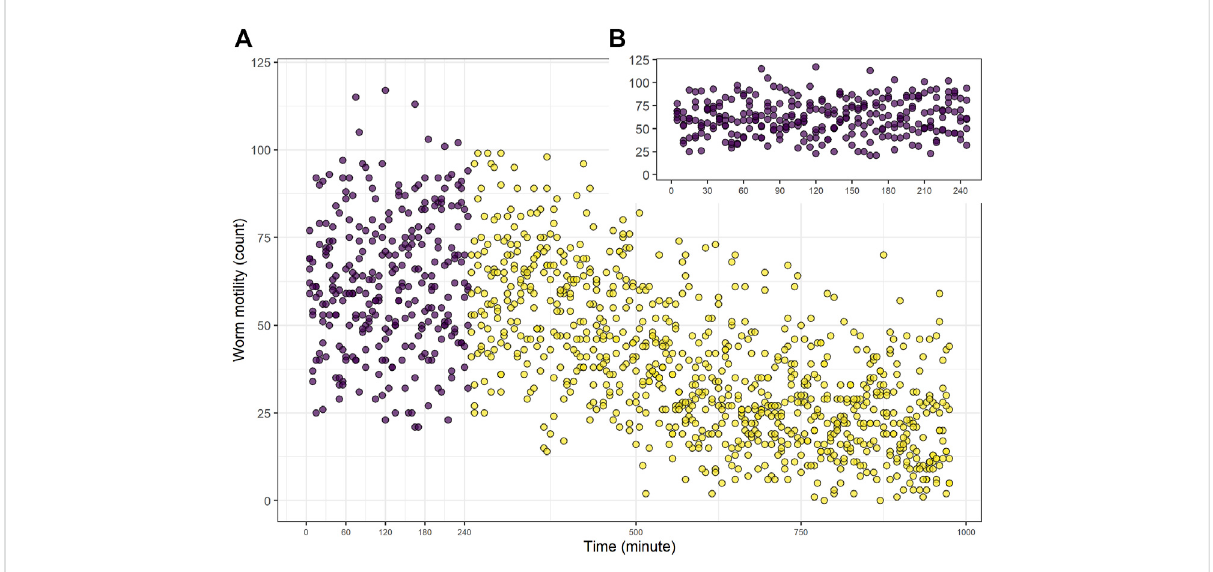
FIGURE 1 Control group worm motility. Control group (vehicle alone, DMSO 0.5%). Worm motility counts per unit of time (5 min) was measured for 980 min (A) Complete assay. Purple dots correspond to the data considered in subsequent dose-response assays (the fi rst 240 min). (B) Inset time from 0 to 240 min only. The data shows a representative